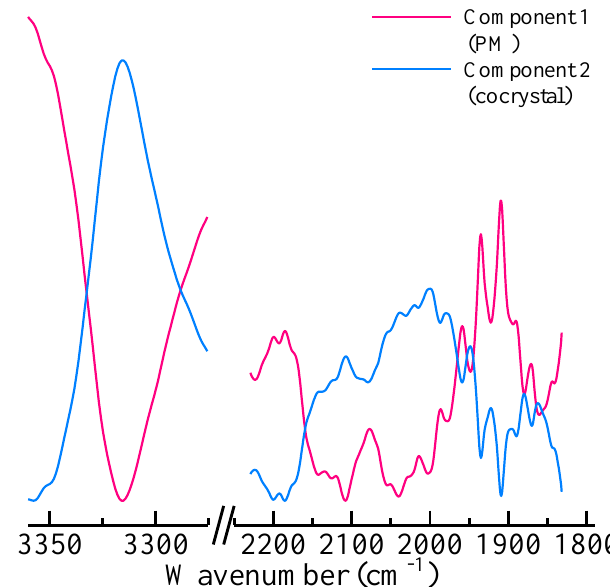
Figure 3. FT-IR spectra of the PM (red, component 1) and cocrystal (blue, component 2) obtained by multivariate curve resolution with alternating least squares (MCR-ALS) analysis. The spectra were deconvoluted into two components.